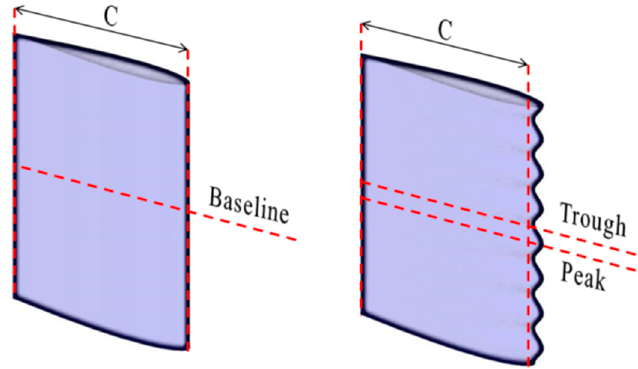
Figure 13. Location of the airfoil section.